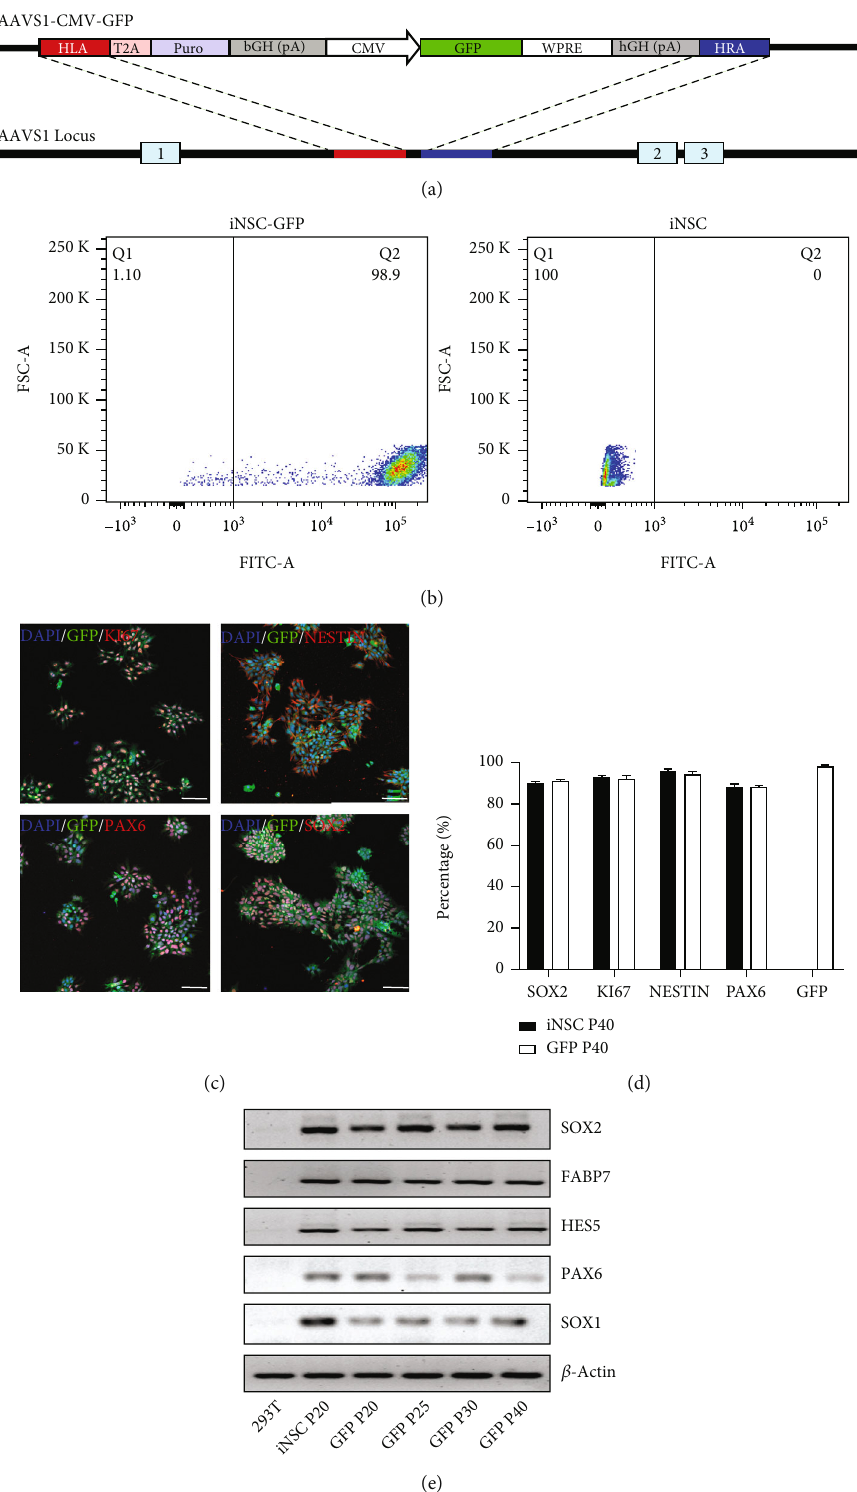
Figure 2: Crispr-Cas9-mediated targeted integration of GFP at the AAVS1 site. (a) Schematic diagram of the knock-in strategy showing the GFP-containing homologous recombination sequence (hAAVS1-CMV-GFP) and the insertion site (hAAVS1 locus). (b) Flow cytometric analysis results of iNSC-GFP and control iNSCs without GFP knock-in. (c) Immuno fl uorescence staining for GFP, NESTIN, KI67, PAX6, and SOX2. Scale bars, 75 μ m. (d) The percentages of iNSCs at passage no. 40 with or without GFP knock-in that were positive for SOX2, KI67, NESTIN, PAX6, and GFP. (e) Expression of SOX1, SOX2, PAX6, HES5, FABP7, and β -actin of 293T, iNSCs of passage no. 20, and iNSC-GFP of passage nos. 20, 25, 30, and 40 at the transcription